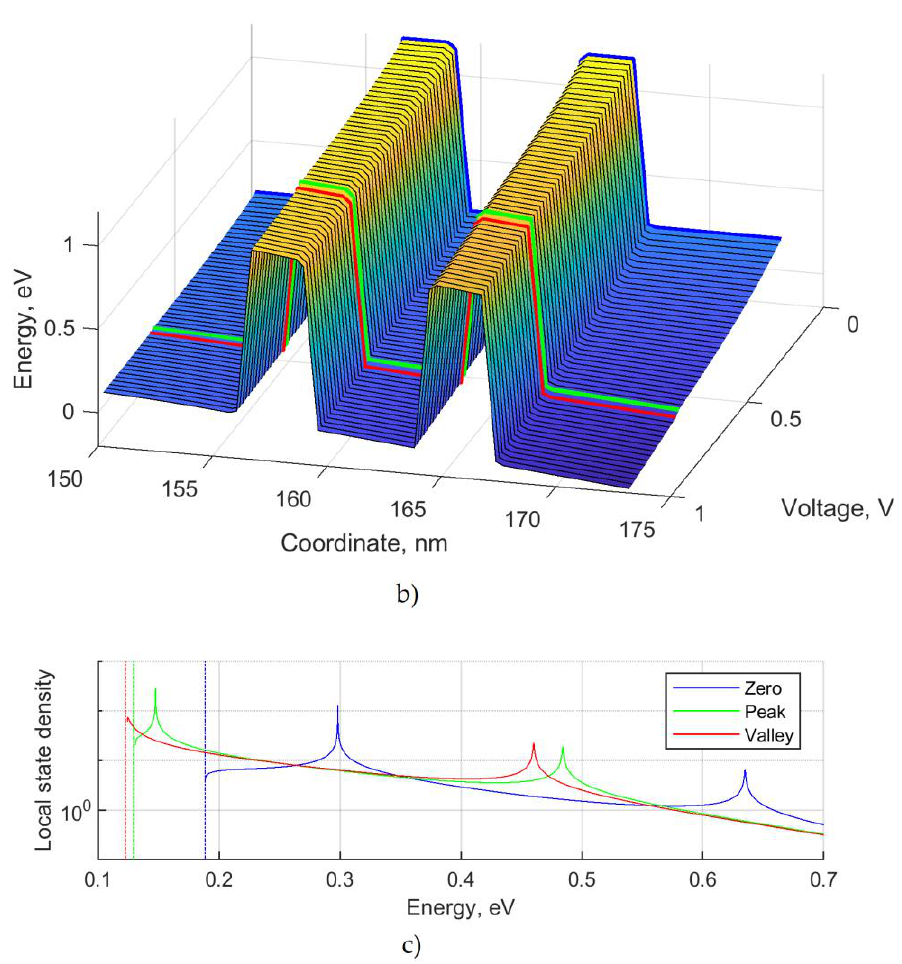
Figure 2. ( a ) Electron concentration (translucent surface—potential energy of electron without self-consistency); ( b ) self-consistent potential; ( c ) local density of states (dashed lines—bottom of conduction zone at source).